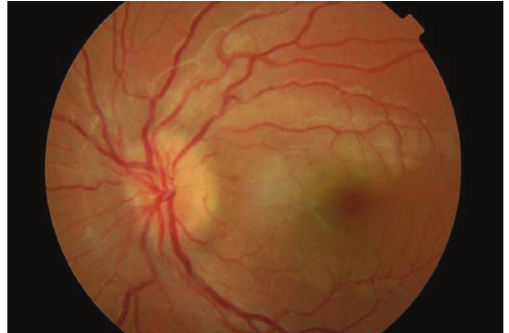
Figure 1: Fundus photography of the patient’s LE at the time of admission in which a remarkably swollen optic disc is illustrated.